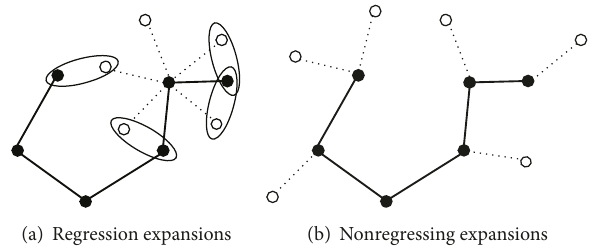
Figure 3: RRT-blossom regression. New point tends to stay away from the existing structure, like the hollow circles.